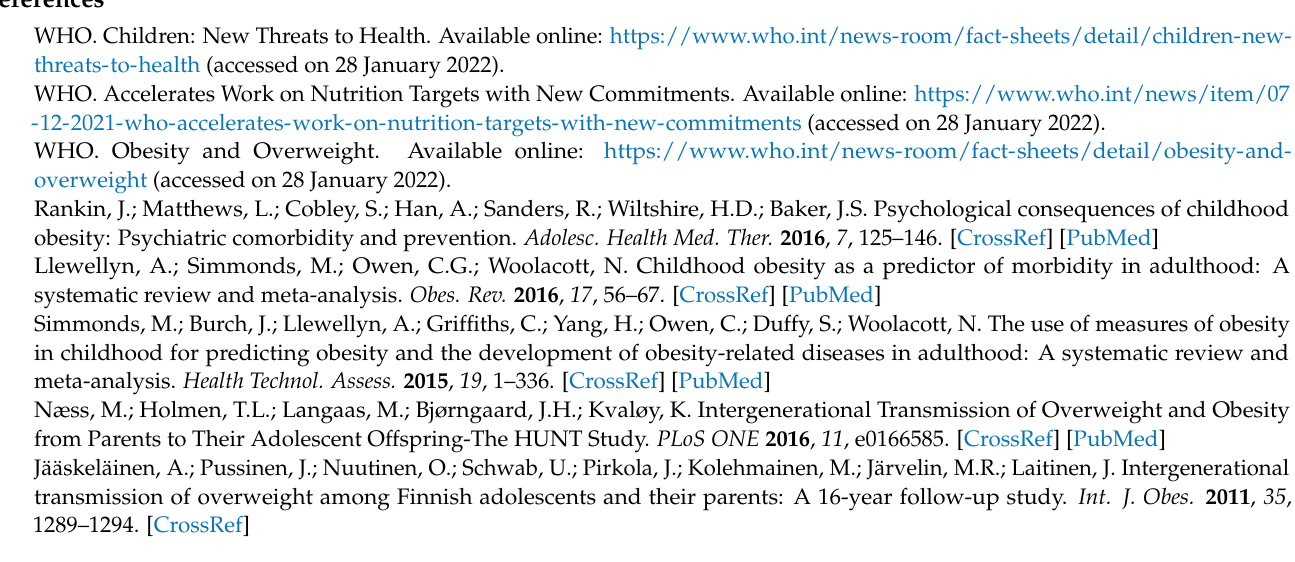
Table S7: Association of OW/OB between parents and offspring, stratified by offspring unhealthy/healthy dietary behaviors. Table S8: Number of each missing variable. Table S9: Sensitive analysis in the association of OW/OB between parents and offspring. Table S10: Association of OW/OB between parents and offspring in sensitive analysis, stratified by parental unhealthy/healthy dietary behaviors. Table S11: Sensitive analysis in the association of OW/OB between parents and offspring, stratified by offspring unhealthy/healthy dietary behaviors. Table S12: Association of OW/OB between parents and offspring in sensitive analysis by to the combination of dietary behaviors in two